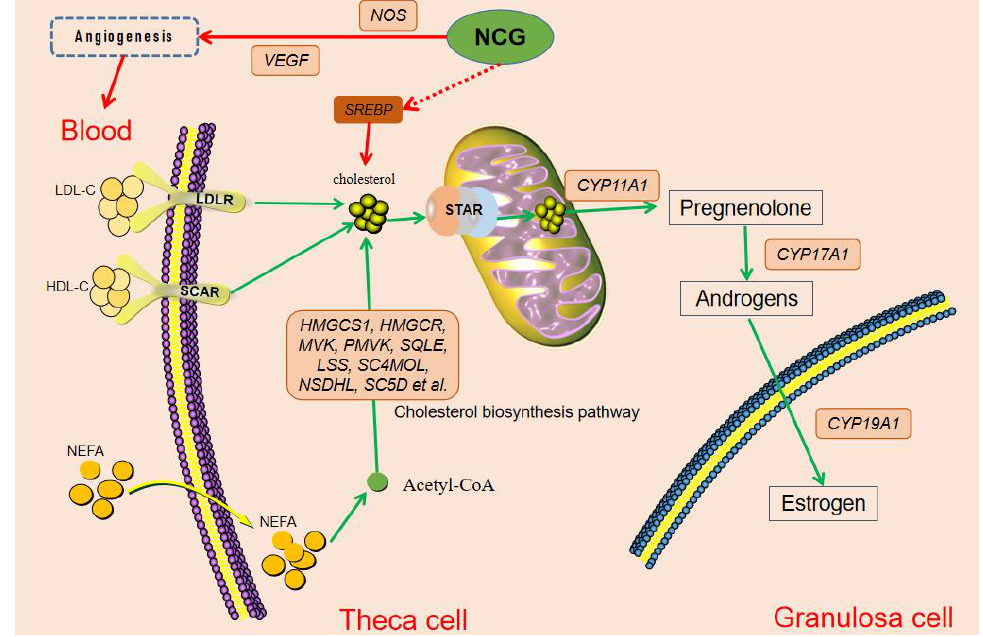
Figure 7. Our proposed model of how N-carbamylglutamate (NCG) regulates cholesterol metabolism, which includes processes related to cholesterol acquisition and steroidogenesis in yak preovulatory ovarian follicles. The red arrows represent processes that NCG affects positively (upregulates) and green arrows represent processes that directly affect cholesterol metabolism.